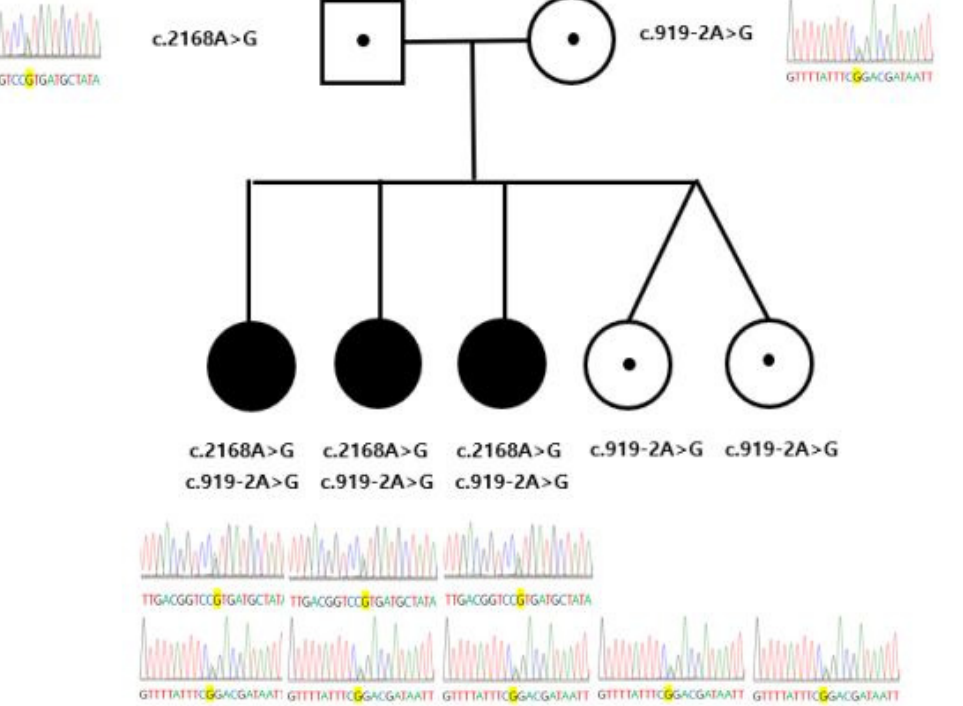
Figure 1. Pedigree of the family and sequencing chromatograms of each family members.